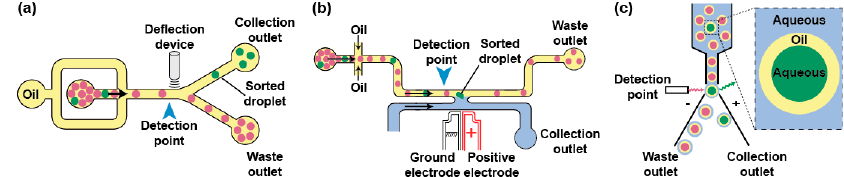
Figure 4. Main droplet sorting strategies. ( a ) Microfluidic droplet sorting using droplet deflection. Droplets are reinjected into a sorting device and spaced by an oil flow. Droplet content (e.g., fluorescence) is analyzed at a detection point (blue arrow) and a deflection device (e.g., pairs of electrodes, surface acoustic wave generator, piezoelectric component…) is activated accordingly to deflect the droplets of interest (green) into the collection channel. ( b ) Droplet sorting based on droplet fusion with an aqueous phase. Droplets are reinjected into the sorting device and spaced by an oil flow. Droplet content (e.g., fluorescence) is analyzed at a detection point (blue arrow) and a pair of electrodes is activated to fuse the droplet of interest with a continuous aqueous flow (blue) accordingly. ( c ) FACS-based droplet sorting. Water-in-oil-in-water droplets are carried by a sheath fluid (blue), analyzed and sorted by